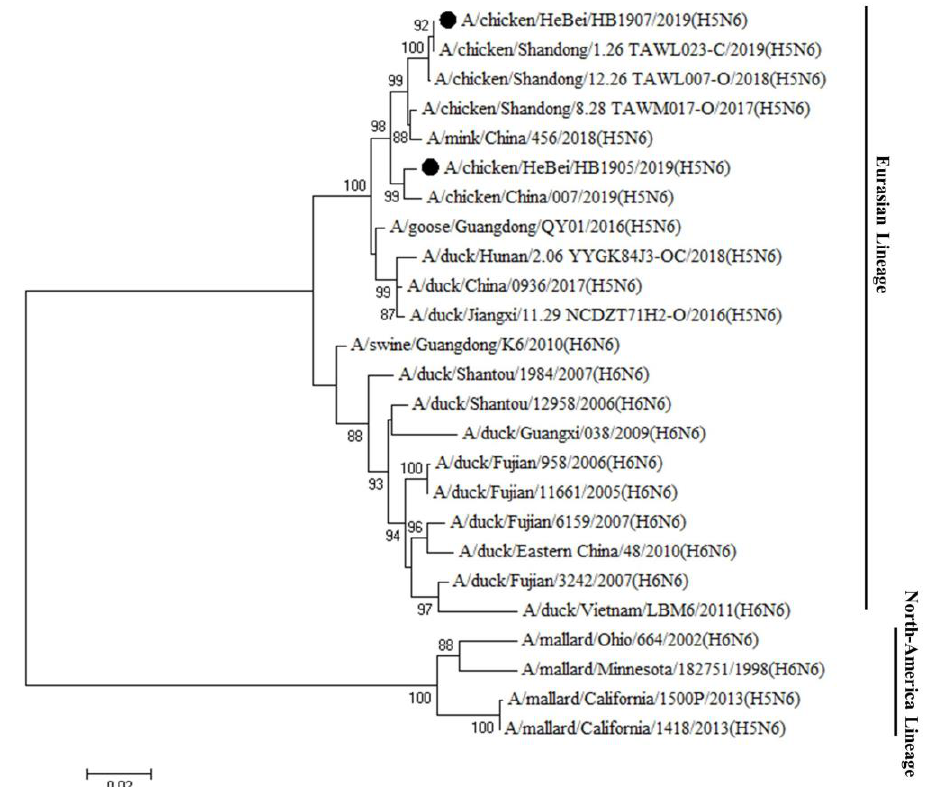
Figure 2. Phylogenetic tree of the NA genes of the H5N6 (HB1905 and HB1907) viruses. The tree was constructed by using MEGA 7.0.21 software using the maximum likelihood (ML) with a bootstrap value of 1000. Sequences in this study are marked with black circles.